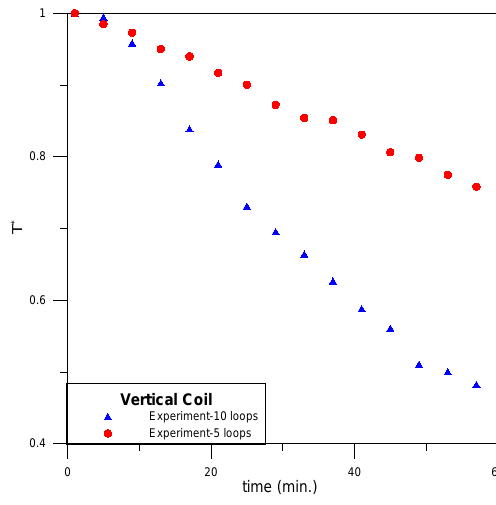
Figure 5. Influence of number of loops.